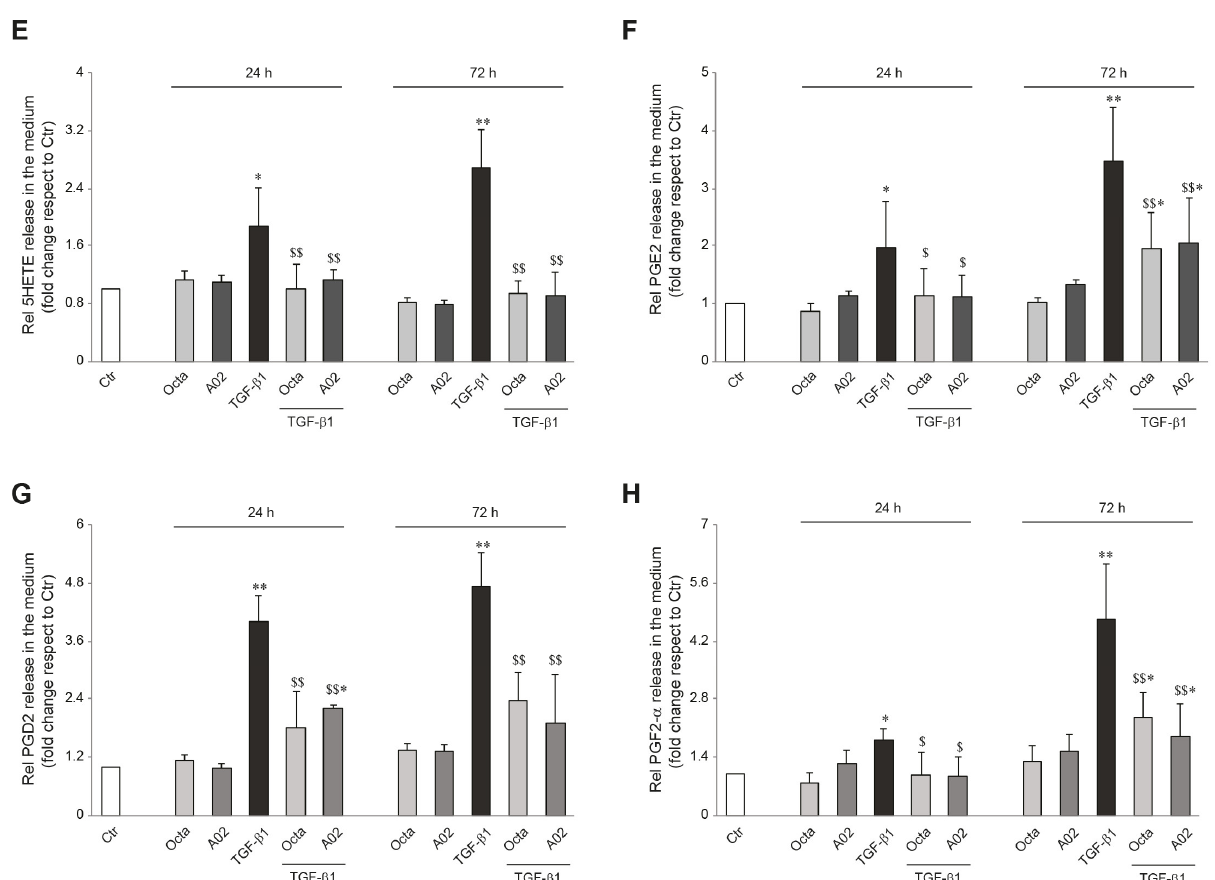
Figure 5. A02 and Octa effects against the alteration of cellular and extracellular lipid composition following the TGF- β 1-induced EMT in A431 cells. Quantification by GCMS of ( A ) cell membrane MUFA/SFA ratio, ( B ) extracellular C16:1/C16:0 ratio, ( C ) extracellular C18:1/C18:0 ratio, and ( D ) cholesterol amount in A431 cells pre-treated with Octa and A02 (90 µ M) for 1 h and then exposed to TGF- β 1 (15 ng/mL) alone or in combination with Octa and A02 for 24 h and 72 h. Quantification by LC-MS/MS of ( E ) 5HETE, ( F ) PGE2, ( G ) PGD2, and ( H ) PGF2 released in the medium by A431 cells pre-treated with Octa and A02 (90 µ M) for 1 h and then exposed to TGF- β 1 (15 ng/mL) alone or in combination with Octa and A02 for 24 h and 72 h. The results are expressed as a ratio or as fold change with respect to control. (* p < 0.05 vs. control; ** p < 0.01 vs. control; $ p < 0.05 vs. TGF- β 1; $$ p < 0.01 vs. TGF- β